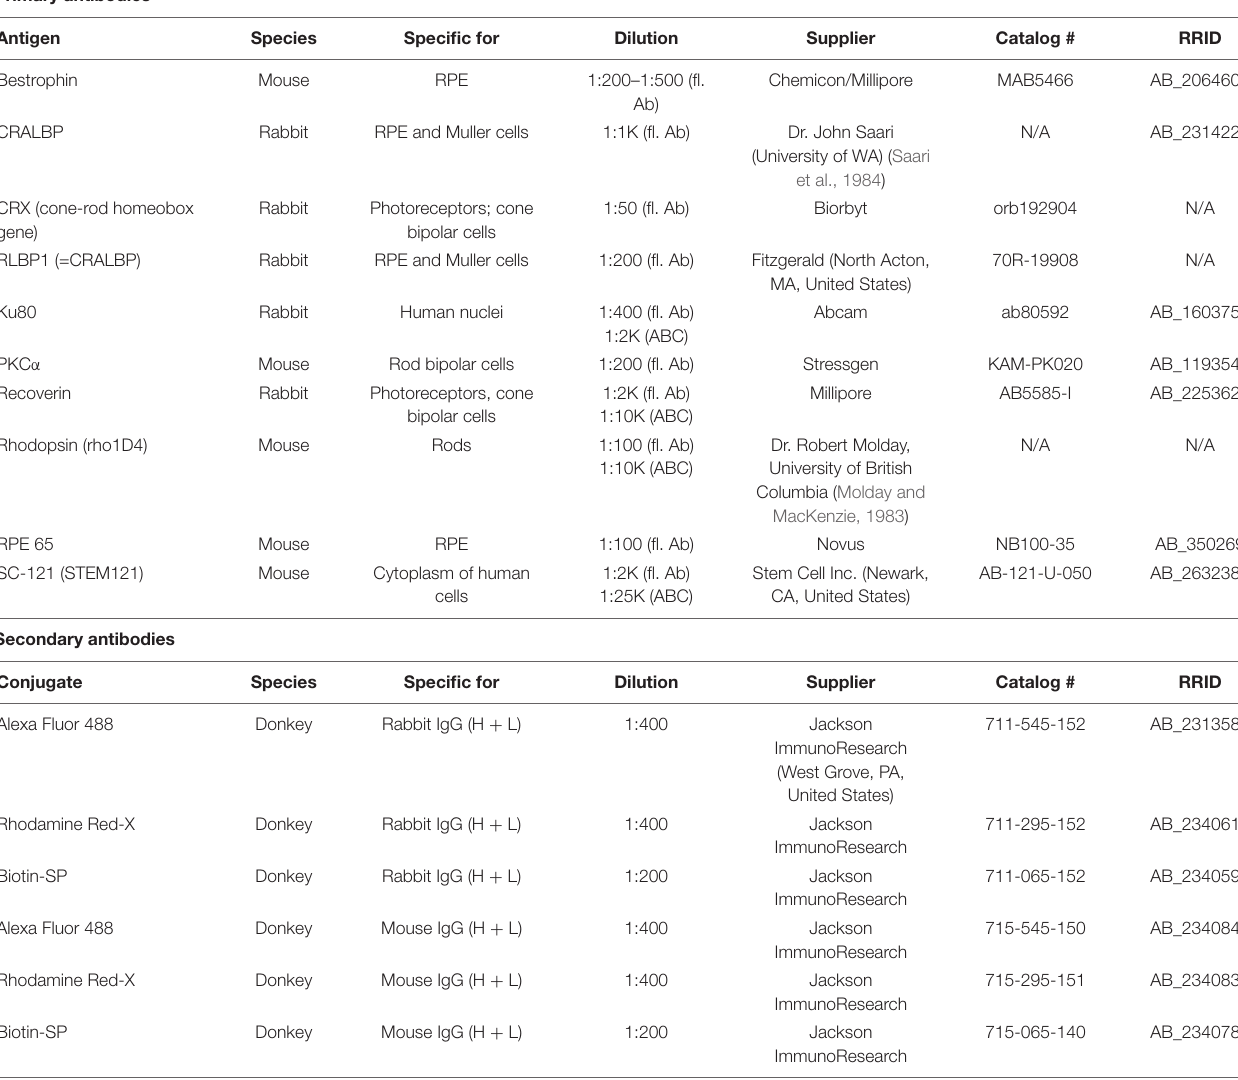
TABLE 2 | List of primary